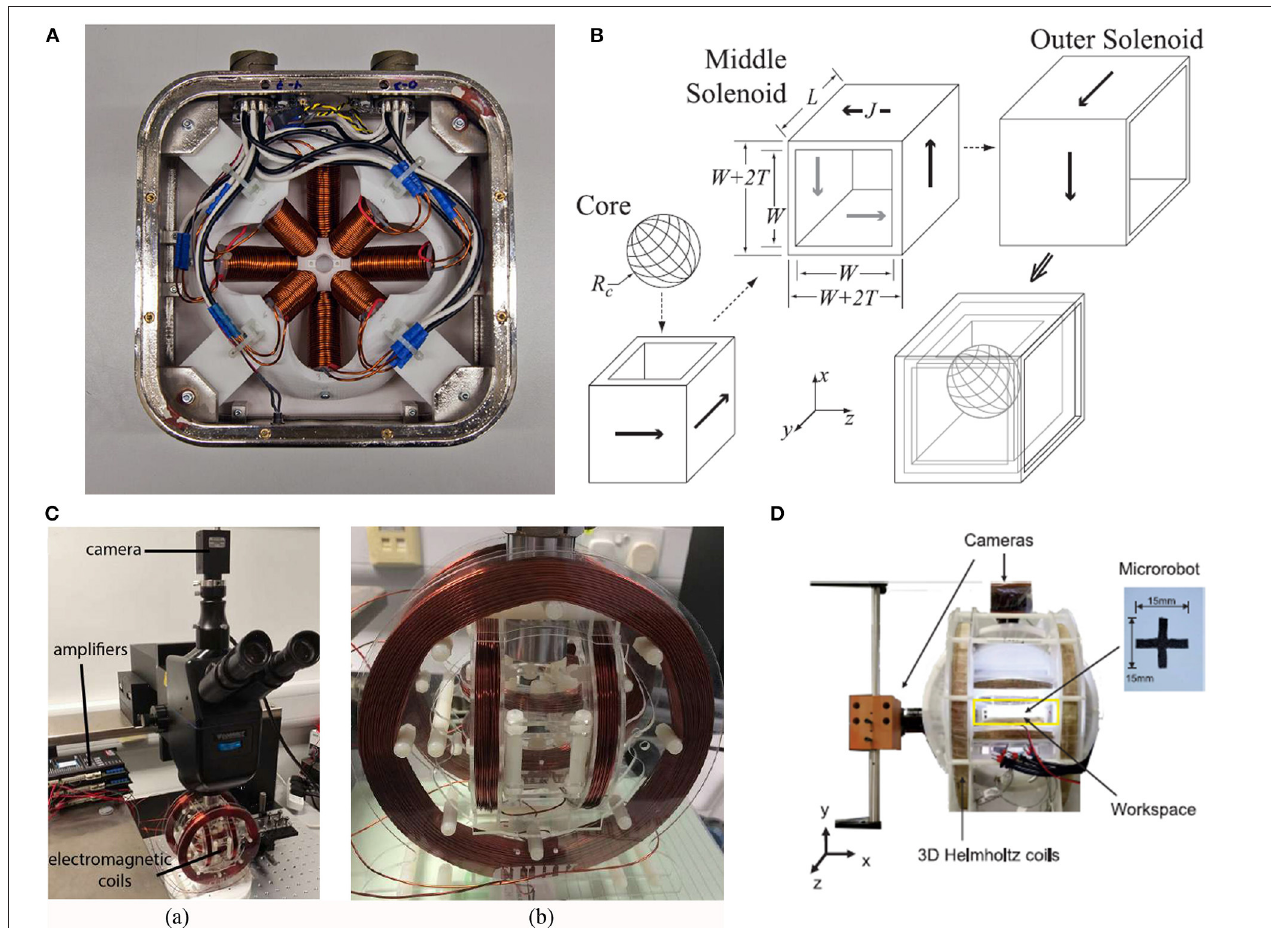
FIGURE 3 | (A) MiniMag control system restricts 8 electromagnetic coils in a fixed hemisphere for the control of micro robots with a small working distance from the system ( Kratochvil et al., 2014). (B) Omnimagnet control system has three nested cubic electromagnetic coils and magnetic ball inside (Petruska and Abbott, 2014). (C) Three-axis Helmholtz electromagnetic coils system with a PointGrey camera and three Maxon motor controllers are used for generating the dynamic magnetic fields ( Yu et al., 2017). (D) 3D helmholtz coils system with two cameras for controlling CTM (Su et al.,